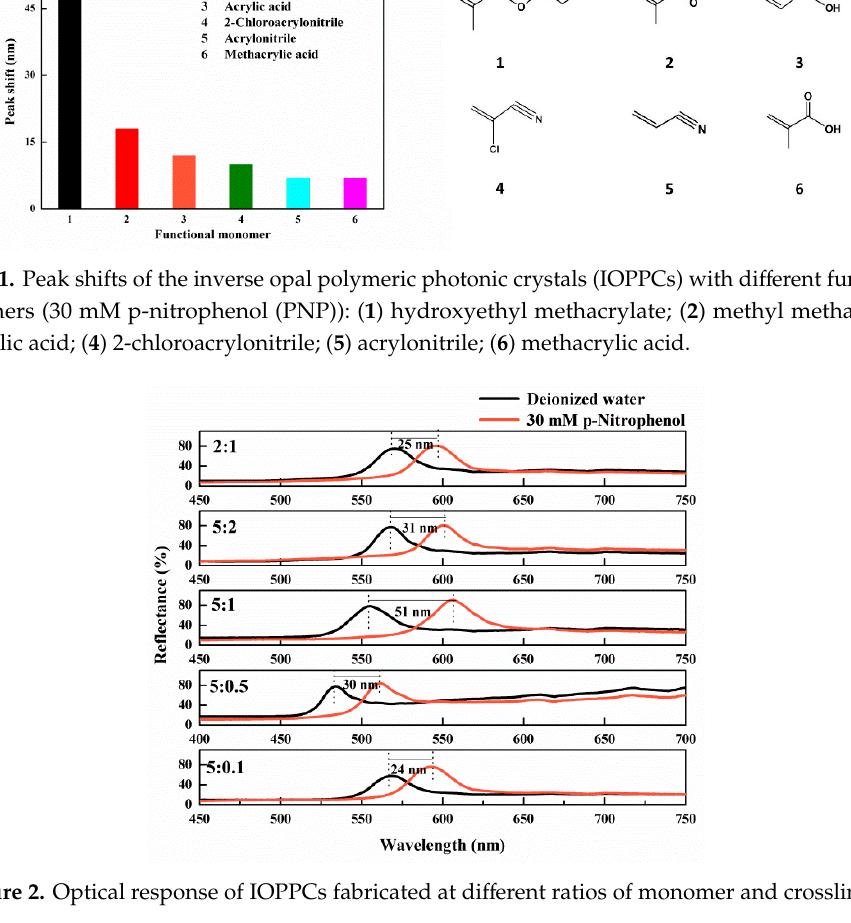
Figure 1. Peak shifts of the inverse opal polymeric photonic crystals (IOPPCs) with different functional monomers (30 mM p-nitrophenol (PNP)): ( 1 ) hydroxyethyl methacrylate; ( 2 ) methyl methacrylate; ( 3 ) acrylic acid; ( 4 ) 2-chloroacrylonitrile; ( 5 ) acrylonitrile; ( 6 ) methacrylic acid.